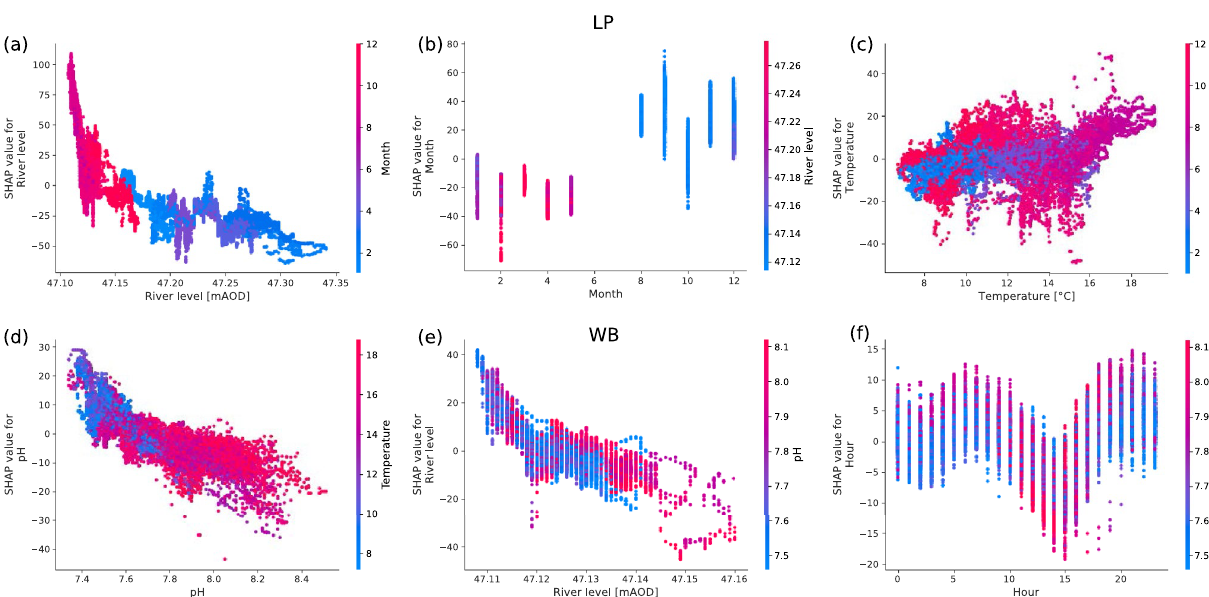
Figure 10. Partial dependency plots of the EC boosted tree for LP ( a-c ) and WB ( d-f ). We plot the three most important features of both downstream measurement sites. The colours (and left-hand side axis) highlight second-order interactions between the plotted feature and a secondary